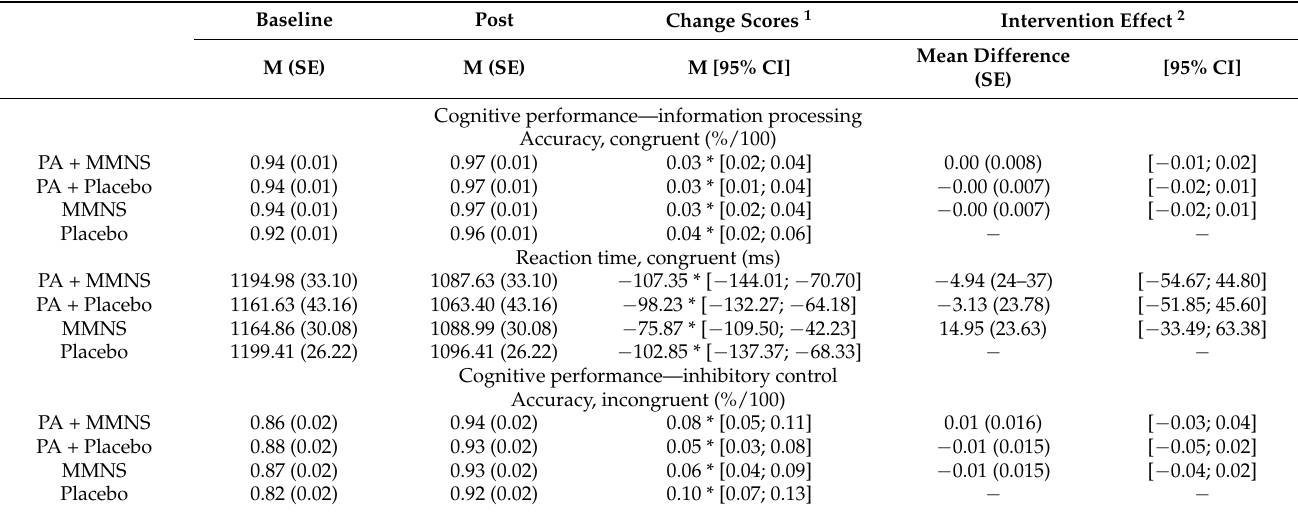
Table 2. Intervention effects on cognitive performance and academic